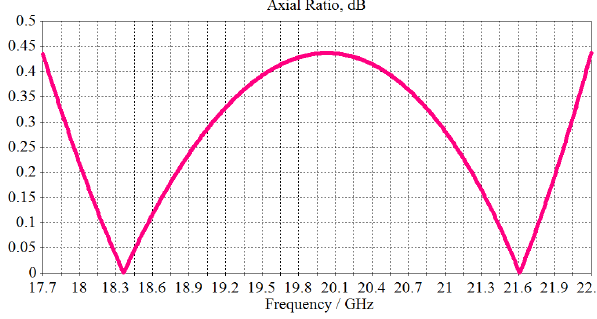
FIGURE 7. Axial ratio (in dB) of the optimized Ka-band waveguide polarizer